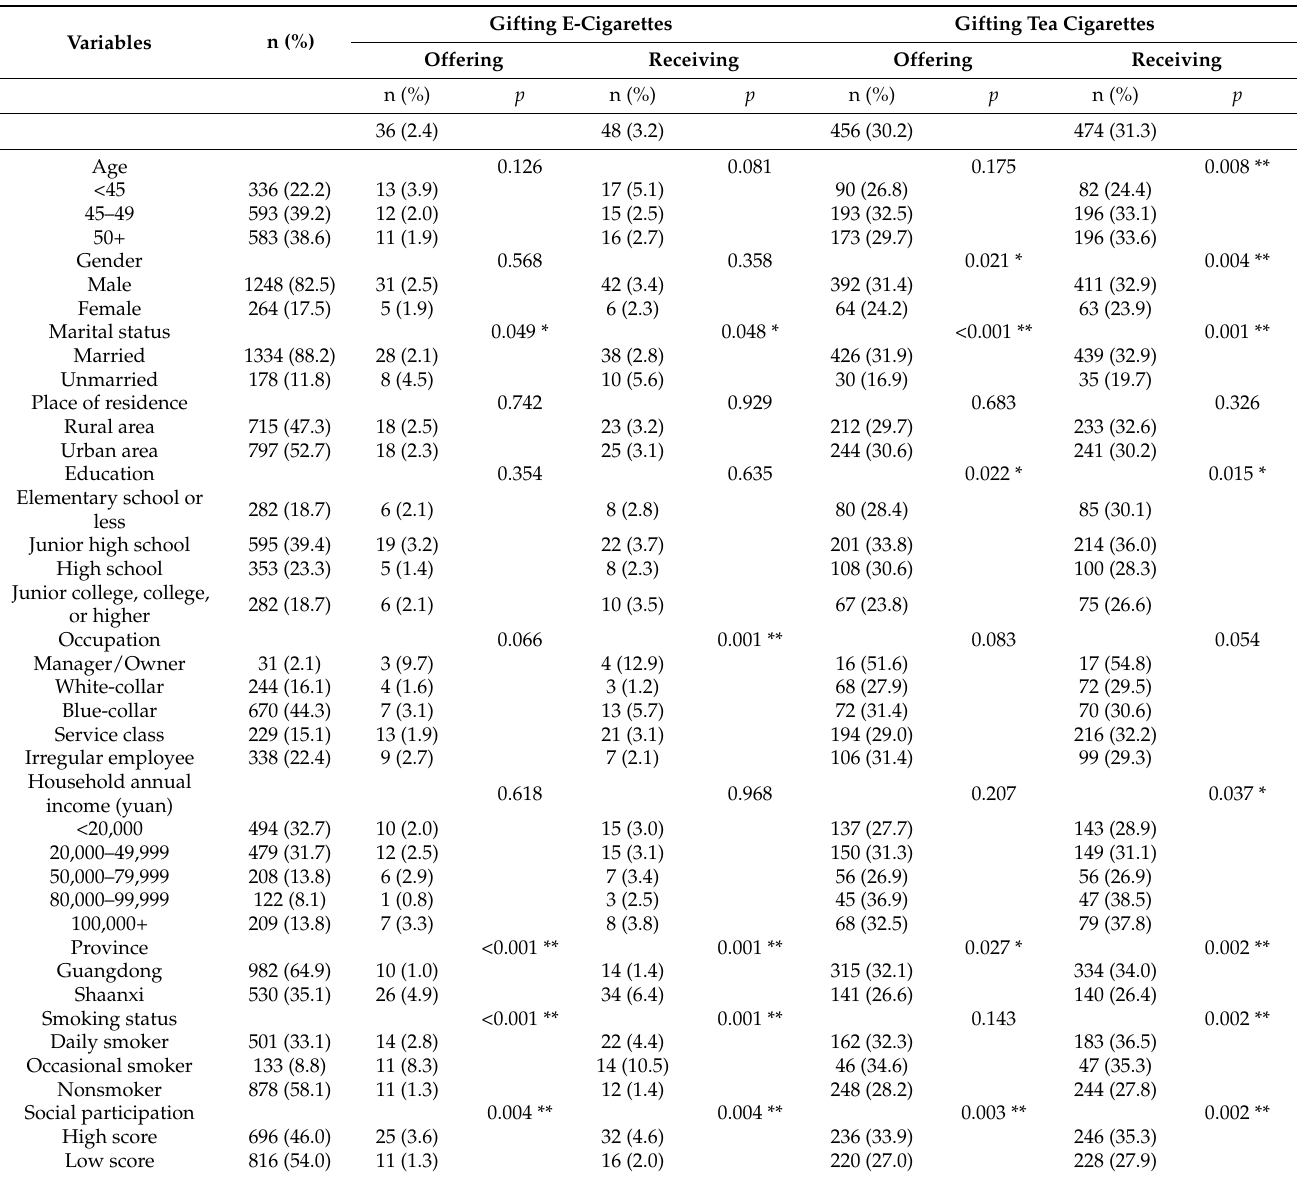
Table 1. Demographic characteristics of the sample and the distribution of e-/tea cigarette